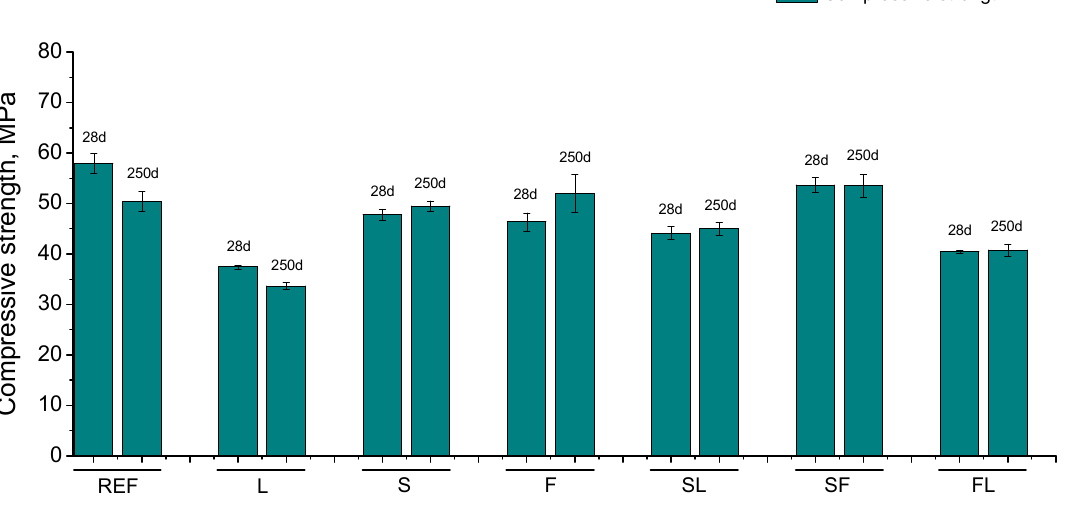
Figure 7. Compressive strength results noted for the analyzed mortars.